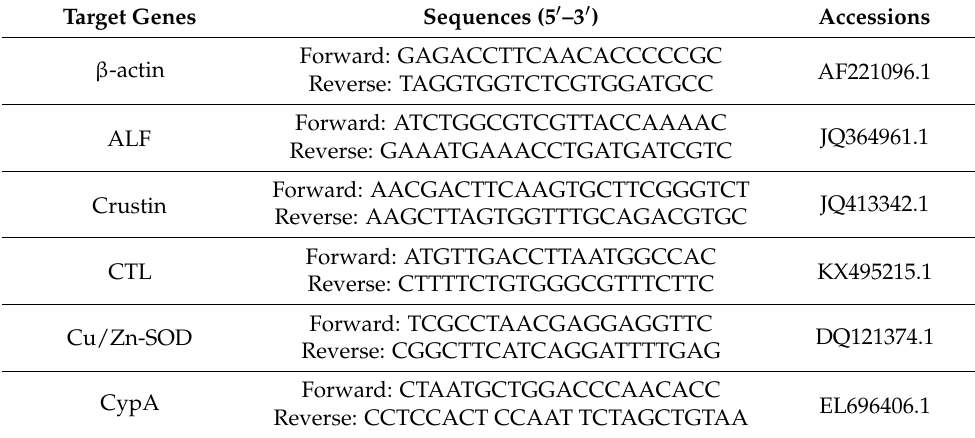
Table 2. Primers used for quantitative real-time PCR